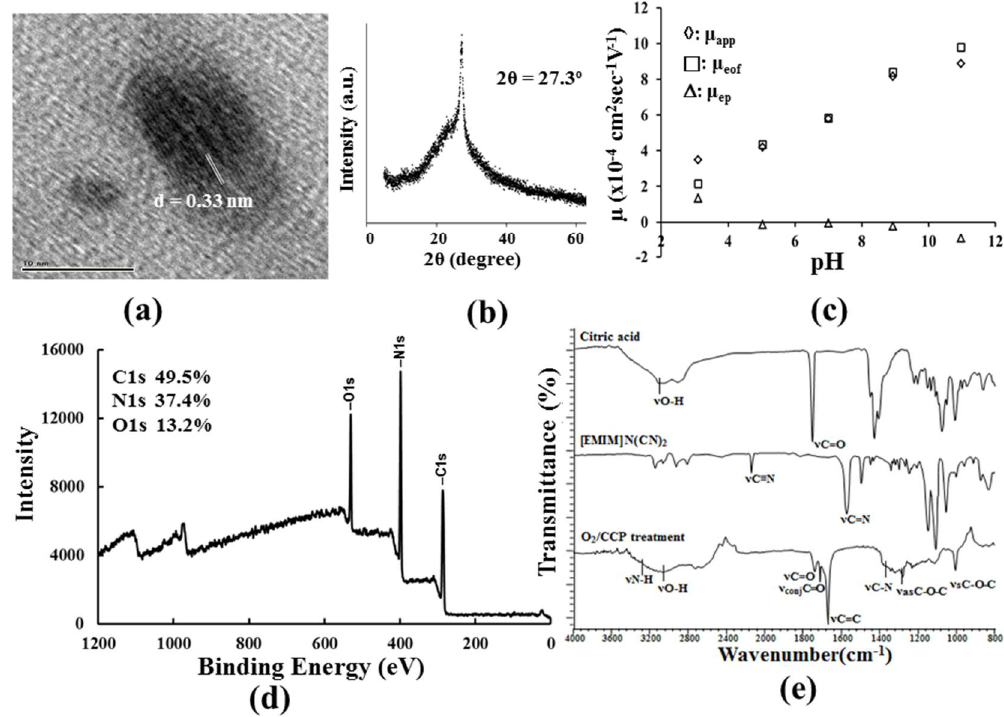
Figure 2. Characterization of the C-dots prepared in the conditions of Figure 1a. ( a ) HRTEM image; ( b ) XRD spectrum; ( c ) the plot of mobility with the pH of the running buffers; ( d ) XPS spectrum, and ( e ) FTIR spectrum.